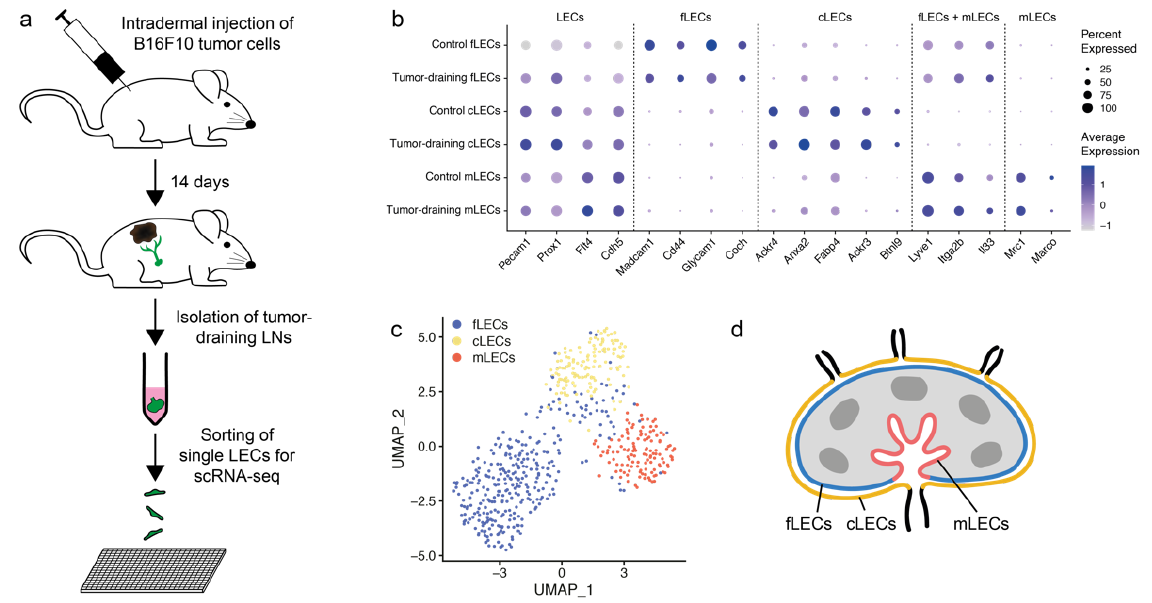
Figure 1. Single-cell RNA sequencing (scRNA-seq) shows persistence of lymphatic endothelial cell (LEC) subsets in lymph nodes (LNs) draining tumors. ( a ) Experimental workflow. B16F10 melanoma cells were injected intradermally into the flanks of C57Bl/6N mice. After 14 days, mice were sacrificed and tumor-draining inguinal LNs collected. LNs were digested enzymatically, the resulting single cell suspension stained for lymphatic markers, and individual LECs sorted by FACS into 384-well plates for scRNA-seq. ( b ) Dot plot showing expression of established LEC and subset marker genes in subcapsular sinus floor LECs (fLECs), subcapsular sinus ceiling LECs (cLECs) and medullary LECs (mLECs) from tumor-draining and control LNs. ( c ) UMAP visualization of all 581 LN LECs used for analysis, 225 from control and 356 from tumor-bearing mice. Cells are colored by cluster; fLECs (blue), cLECs (yellow), and mLECs (red). ( d ) Schematic illustration of LEC subtypes within the